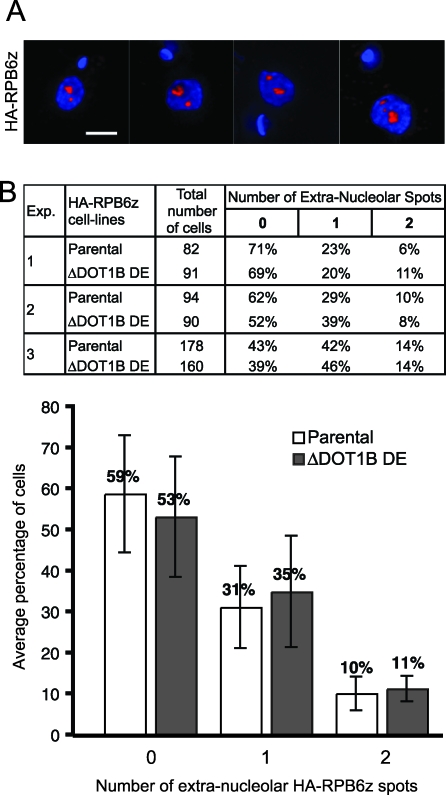
Frequency of Extranucleolar Spots Is Identical in Parental and ΔDOT1B Double-Expresser HA-RPB6z Clones(A) Examples of four nondividing bloodstream cells expressing HA-RPB6z, detected by HA.11 monoclonal antibody. DNA was detected with DAPI (blue). Scale bar: 2 μm.(B) Quantification of cells containing 0, 1, or 2 extranucleolar spots in parental and ΔDOT1B double-expresser (DE) HA-RPB6z clones. The total number of cells and the percentage in each category is indicated for three independent experiments. The average values from the three experiments are shown as a histogram.